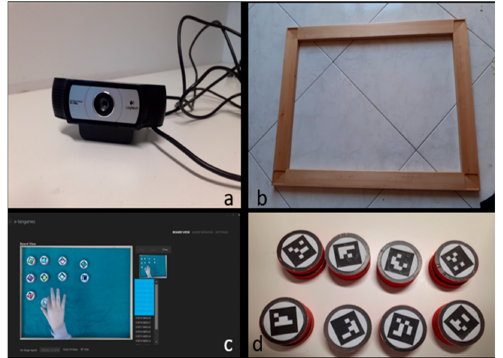
Figure 1. Some pictures of the E-BTT apparatus: ( a ) the Logitech C930e webcam camera (Newark, CA 94560, USA); ( b ) the wooden frame; ( c ) a screenshot from the board view of the software platform; ( d ) the 5 cm disks with ArUco markers on